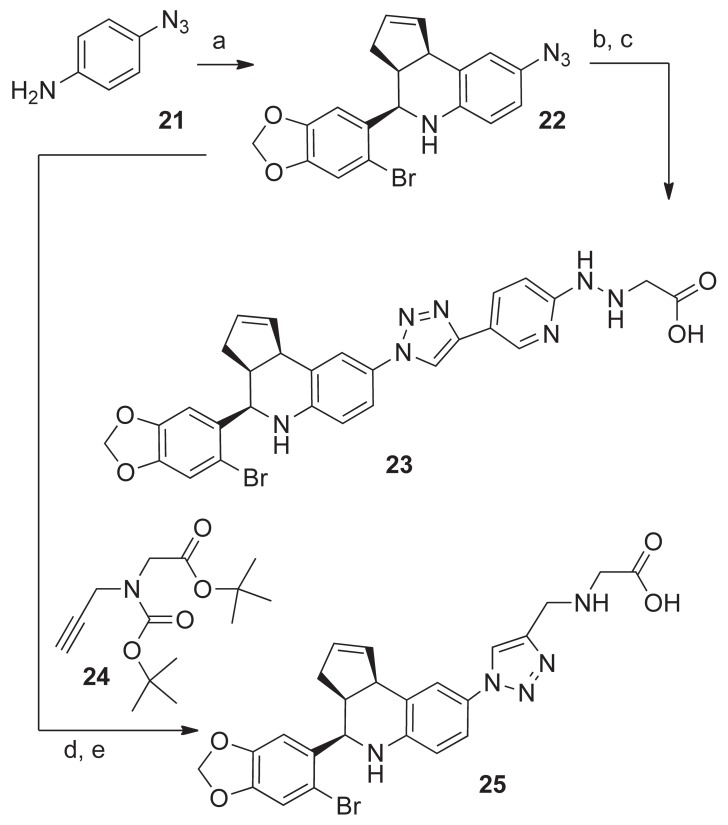
Synthesis of triazole ligands 23 and 25.Reagents and conditions: a) 21, 6-bromopiperonal (1 eq), cyclopentadiene (5 eq), Sc(OTf)3 (10 mol%), rt, 4 h, 22 90%; b) 12 (1 eq), CuSO4
5H2O (10 mol%), sodium ascorbate (20 mol%) H2O/tBuOH (1∶ 1), 60°C, 20 h, 52%; c) TFA/DCM (0.8∶1.0), 45 min, 23, 96%; d) 22 (1eq), 24 (1 eq), CuSO4.5H2O (10 mol%), sodium ascorbate (20 mol%) H2O/tBuOH (1∶1), 60°C, 3 h, 60%; e) TFA/DCM (0.8∶1.0), 2.0 h, 25, 75%.